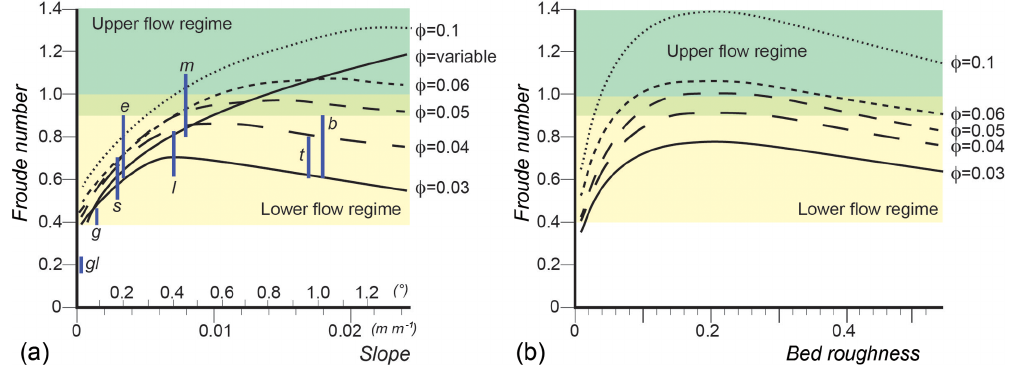
Figure 3. Relationships between (a) channel slope and Froude number F and (b) relative bed roughness and F . These were calculated as a function of various Shields (1936) variables φ . The pale green field indicates the conditions where an upper flow regime could prevail, while the yellow field delineates the occurrence of lower flow regime conditions. In this context, we set the threshold to a Froude number of ca. 0.9. This is consistent with the estimation of parameters for the formation of upper flow regime bedforms by Koster (1978). Note that the bed roughness is the ratio between the D 84 and the water depth d at the onset of motion of that particular size class. The vertical bars on (a) also illustrate the Froude numbers that have been estimated by Spreafico et al. (2001) for the following streams and locations. b : Birse-Moutier, e : Emme-Burgdorf, gl: Glatt-Fällanden, g : Gürbe-Belp, m : Minster-Euthal, l : Lütschine-Gsteig, s : Suze-Sonceboz, t : Thur-Stein. Please note that the low values for the Thur and Birse rivers might represent underestimates as these streams show evidence for multiple hydraulic jumps during high-stage flows.